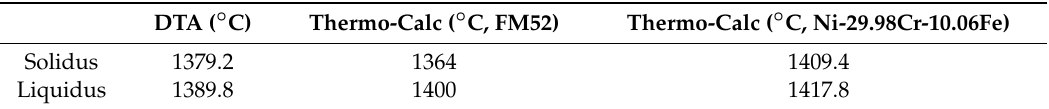
Table 2. Results of the differential thermal analyses (DTA) and thermodynamic calculations with the TTNi8 database.